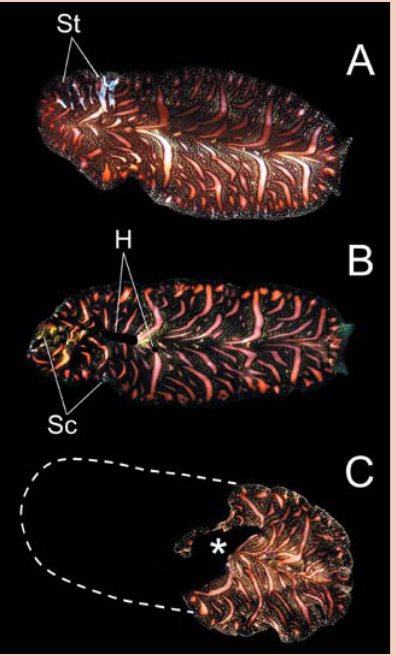
Figure 2. Scars of Sex (A) Streaks of sperm (St) received after a mating interaction in the hermaphroditic fl atworm, Pseudobiceros bedfordi . (B) Received sperm appears to “burn” holes (H) in the receiver. Some (unknown) component of the ejaculate dissolves the skin tissue. Sc, scar tissue. (C) Exceptional case where an individual received a large amount of sperm somewhere in the middle of the body, resulting in a large hole (asterisk). The the body subsequently tore in two. Individuals like these are occasionally found in the fi eld and can regenerate much of their body. Photo courtesy of Nico Michiels.